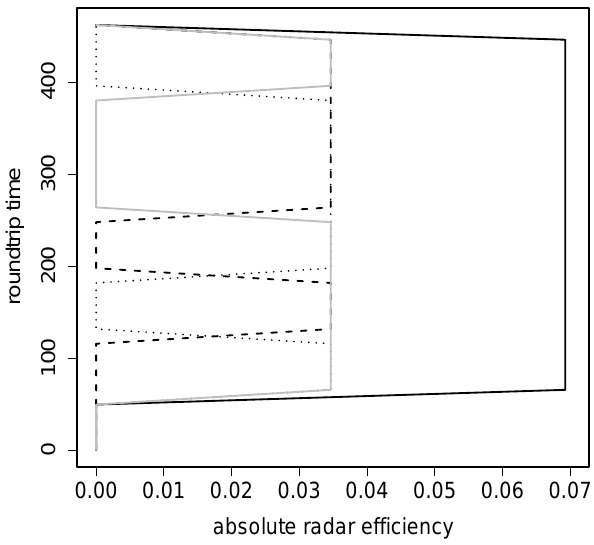
Fig. 1. The absolute radar efficiency of zero-lag of a PPATC ex- periment with a pulse length of 16 units and three different IPPs (66, 132 and 264 units). The dashed, dotted and grey lines are the efficiencies of the three individual pulses. The solid black line is the total efficiency of the experiment. A time period of 50 units, in addition to the pulse length, is assumed to be lost during each